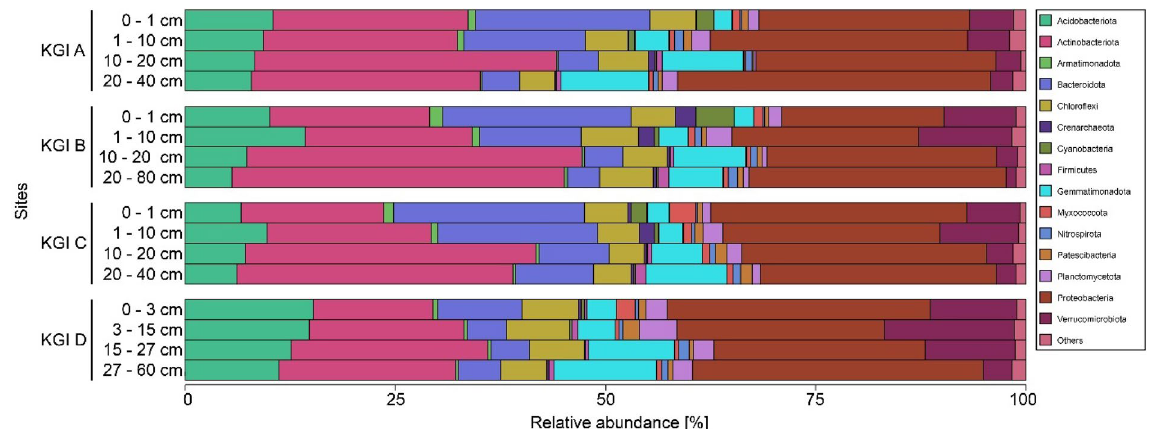
Figure 4. Relative abundances of phyla of three soil profiles (KGI A, KGI B, KGI C) in the recently deglaciated foreland of the Ecology glacier and one soil profile distal to the lateral moraine (KGI D) on King George Island, South Shetland Islands. Sample triplicates are merged. Only phyla with an abundance of at least 1% at a given site are presented. Less abundant phyla are summarized as